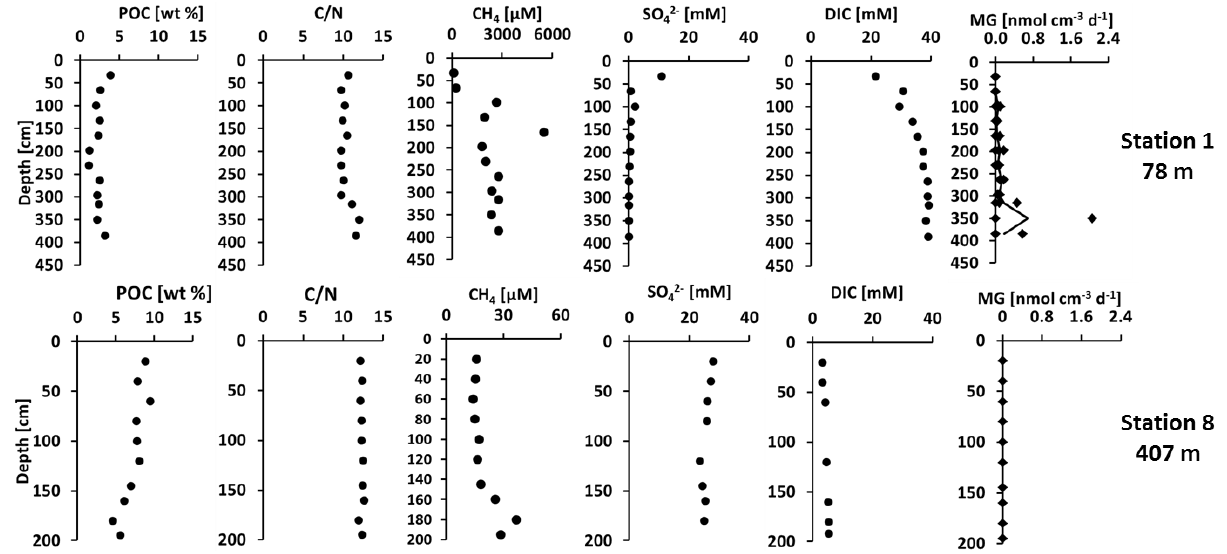
) , dissolved inorganic carbon (DIC), and 4